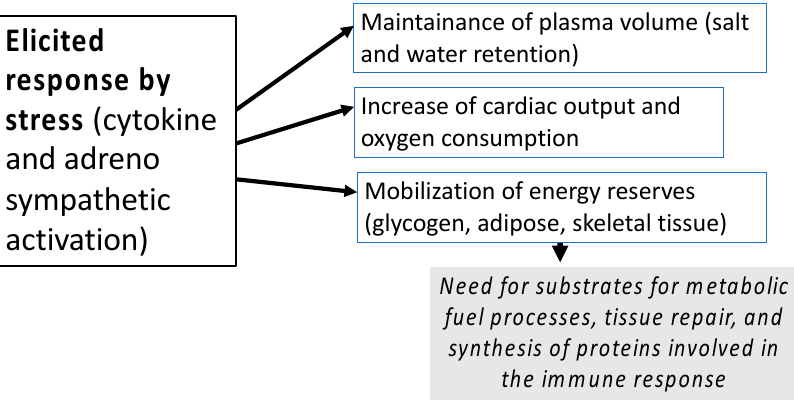
Figure 2. The consequences of the elicited stress reaction.